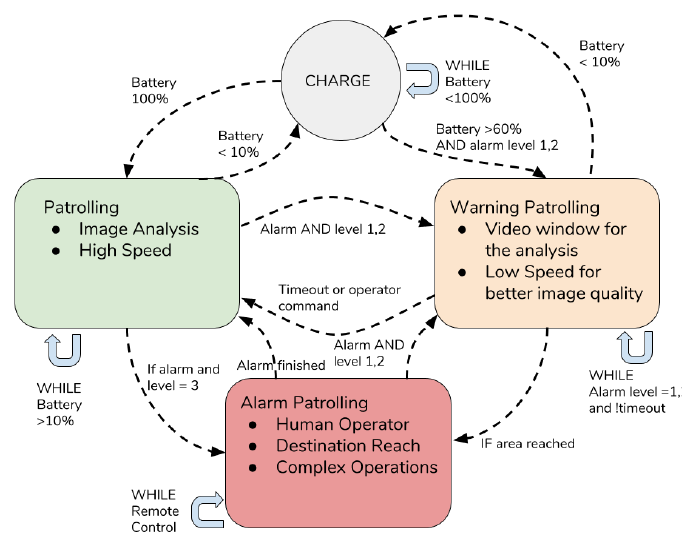
Figure 5. Finite state machine (FSM) of the